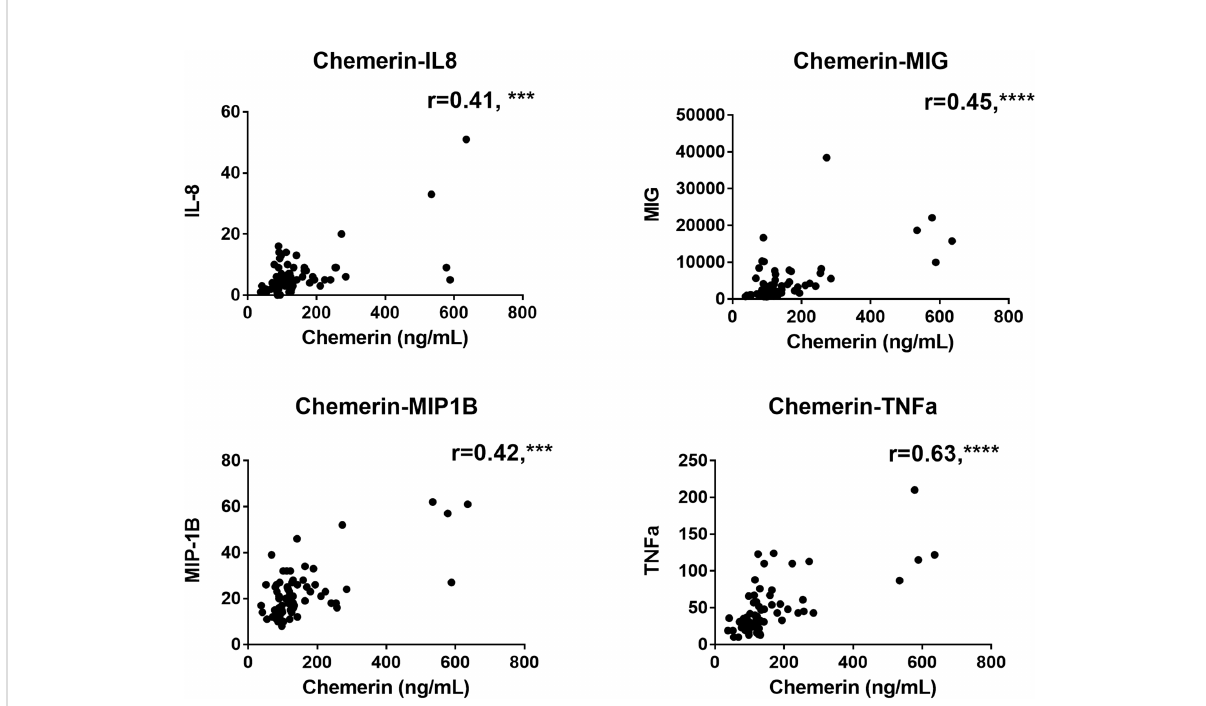
FIGURE 3 Correlations analysis between chemerin concentration and the levels of different cytokines and chemokines measured by multiplex in plasma of COVID-19 patients at all time-points. The r corresponds to the Spearman coef fi cient for non-parametric correlation. IL-8: interleukin 8; MIG: monokine induced by interferon- g ; MIP-1 b : macrophage in fl ammatory protein-1 b ; TNF a : tumor necrosis factor a . N=70 for all analysis. ***: p<0.001; ****: